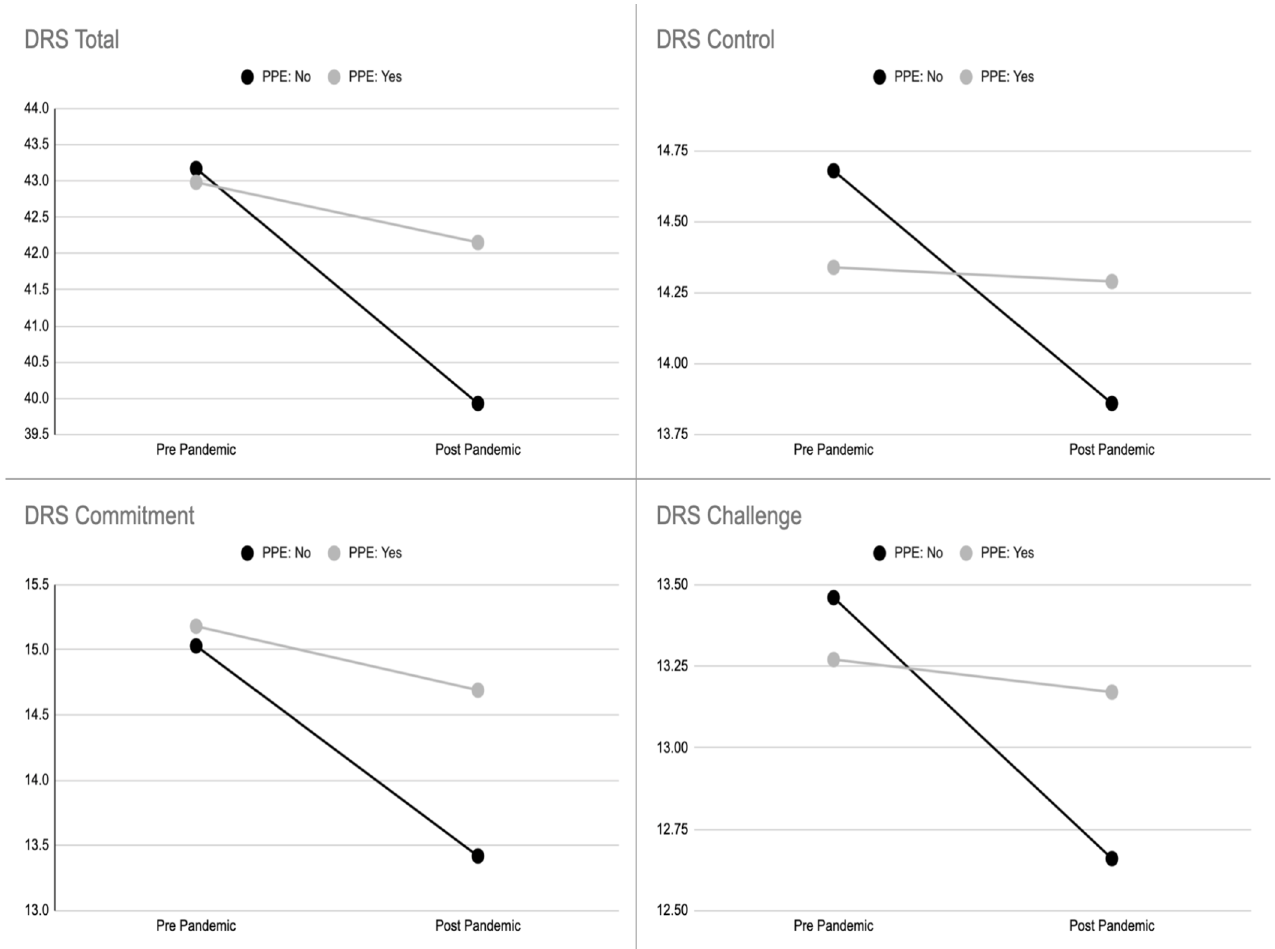
Figure 2. Hardiness levels (total, commitment, control, and challenge) of nurses taking care of COVID-19 patients, shown in the two subsamples of those adequately provided with PPE and those who were not. who were